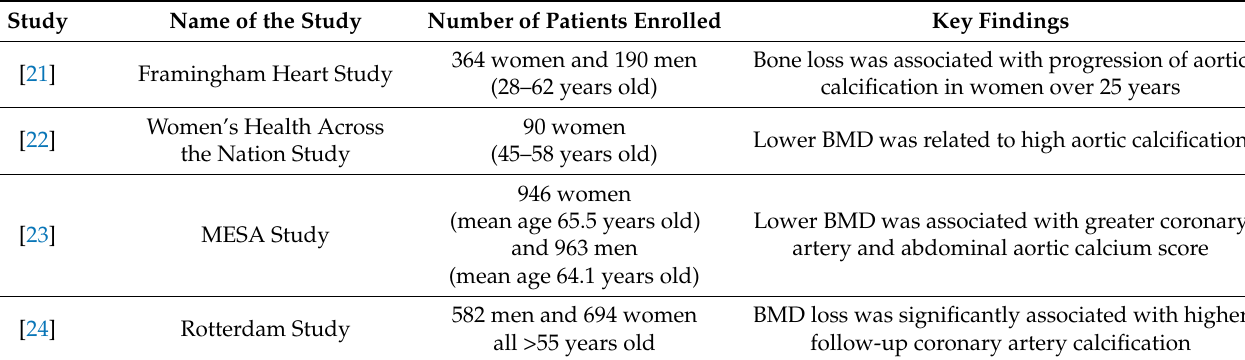
Table 1. Clinical evidence linking bone loss to vascular